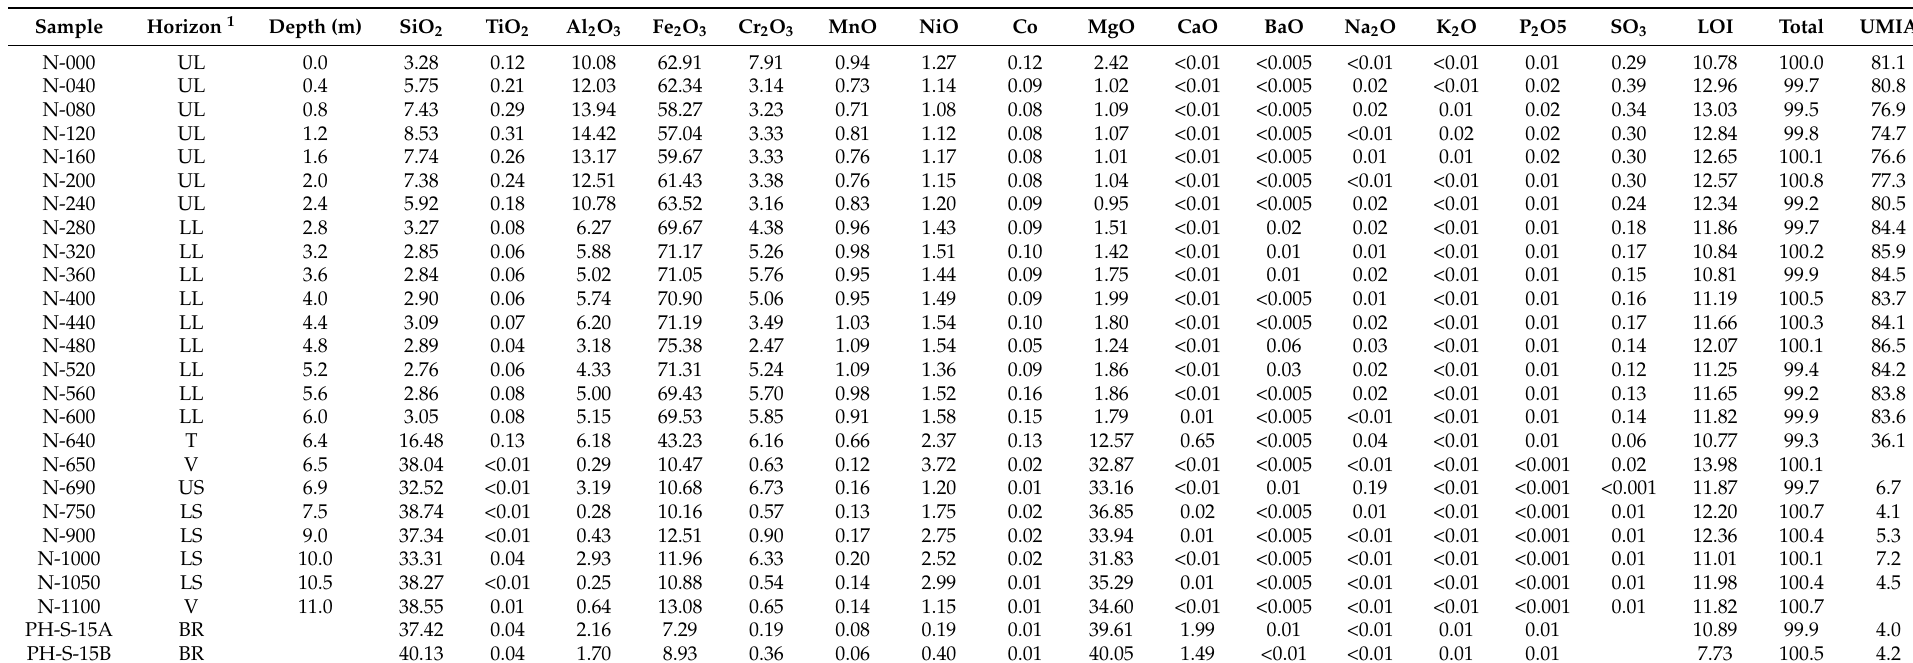
Table 2. Bulk geochemistry and ultramafic index of alteration (UMIA) of samples from the Sta. Cruz nickel laterite. All compositions are in